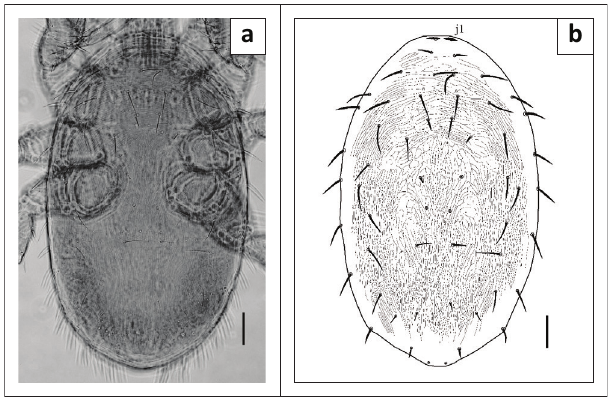
FIGURE 2: Parasteatonyssus nyctinomi , ♂ : (a) photograph, dorsal view; (b) drawing, dorsal shield. Scale bar: 50 μ